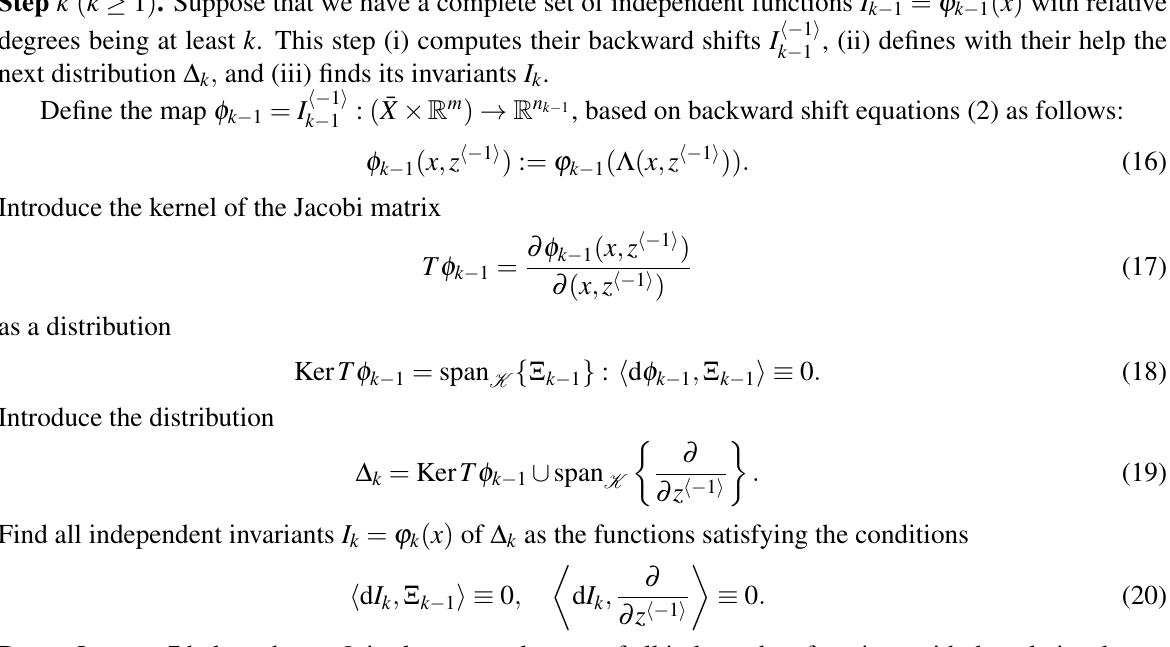
Algorithm 1. Computation of distributions ∆ k and their